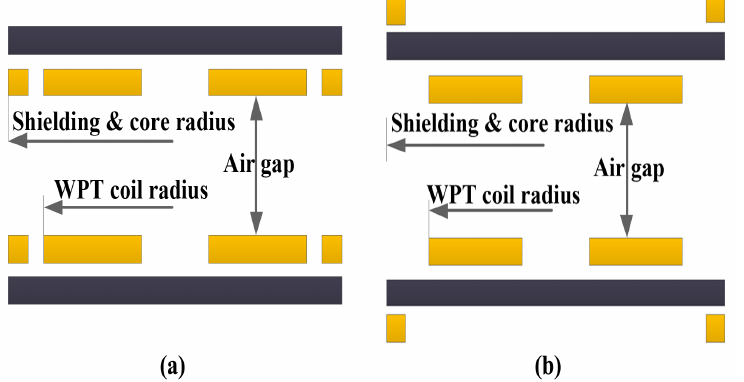
Figure 16. The proposed shielding loop positions; ( a ) the two loops on the same levels with the WPT coils, and ( b ) the two loops located above and under the ferrite